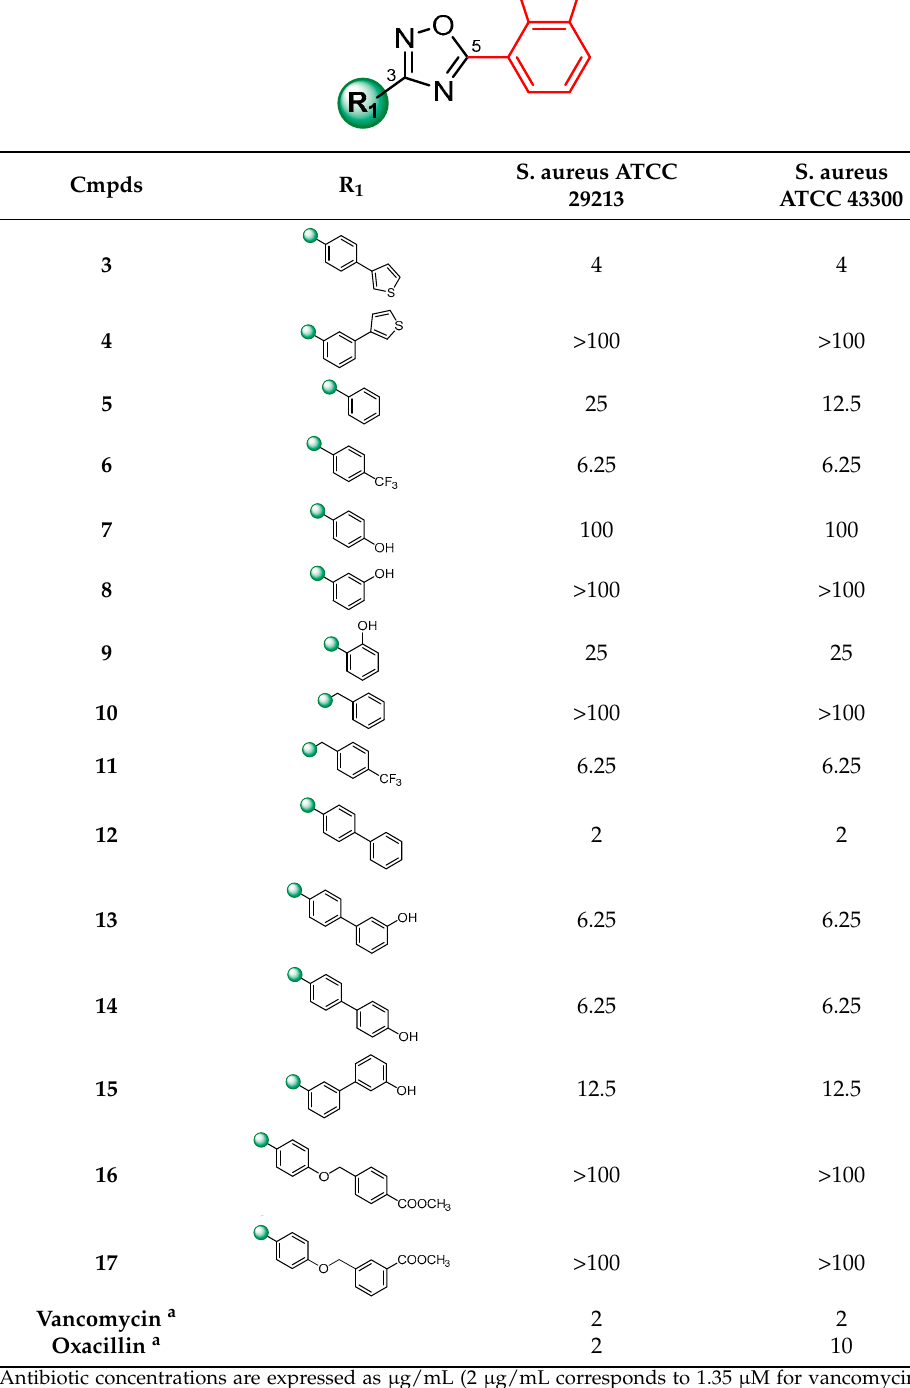
Figure 3. Time-kill assay of compound 12 against S. aureus ATCC 29213 and S. aureus ATCC 43300. Each experiment is the result of three independent experiments performed in triplicate. 2.3. Synergistic Study